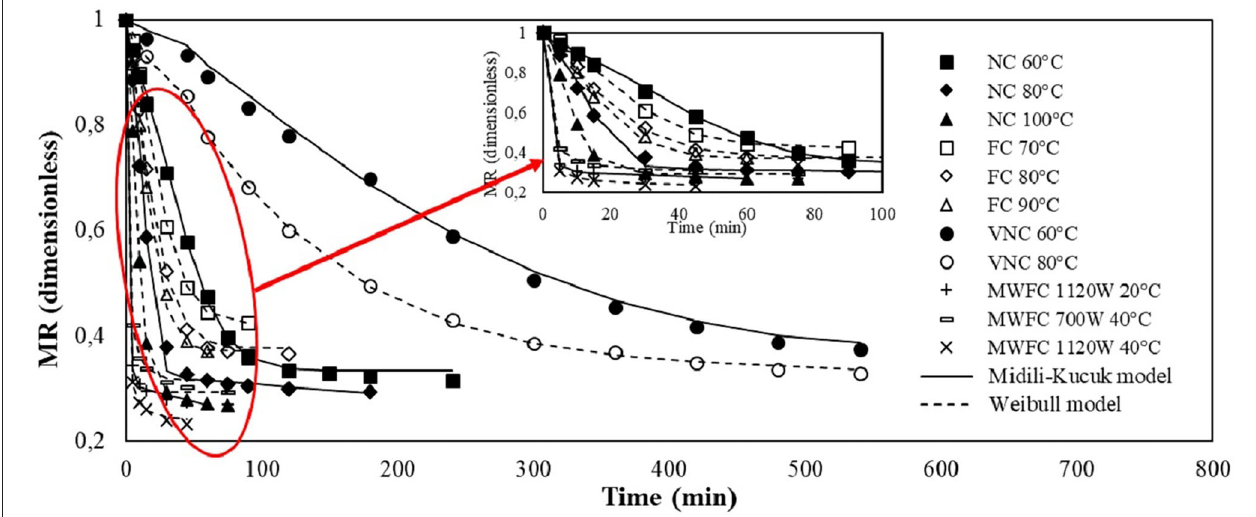
FIGURE 3 | Drying curves predicted by Midilli-Kucuk and Weibull models with the lowest RE values for each drying curve.